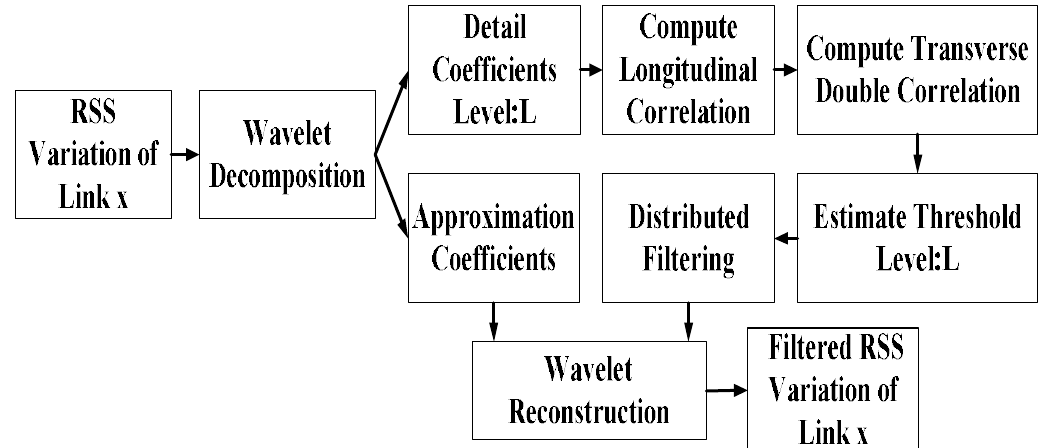
Figure 4. The overall architecture of the TDDC distributed wavelet filtering.